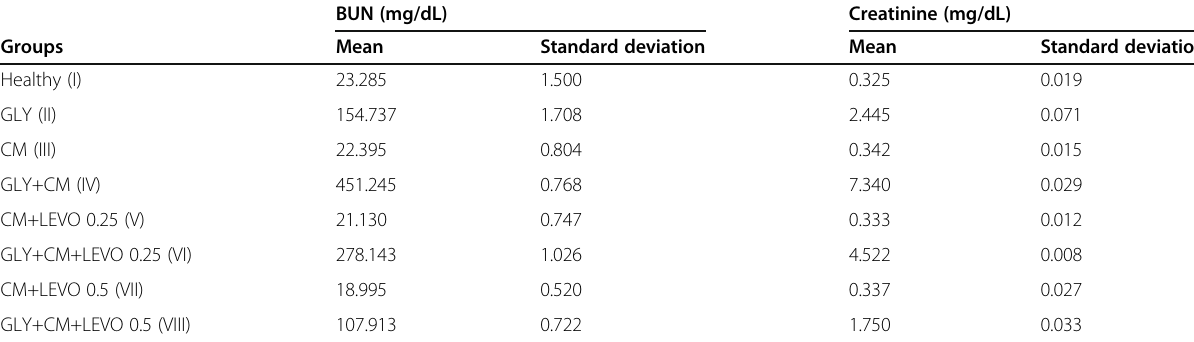
Table 1 The mean blood urea nitrogen (BUN) and creatinine levels according to experimental groups BUN (mg/dL) Groups